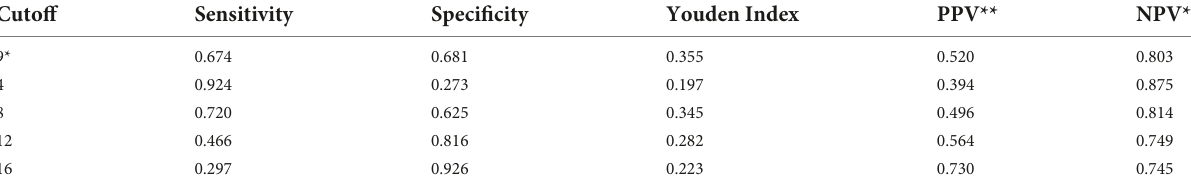
TABLE 5 Quality of life and disability according to SSS-8 severity category in tertiary hospital patients in China. SSS-8 severity category (Range)